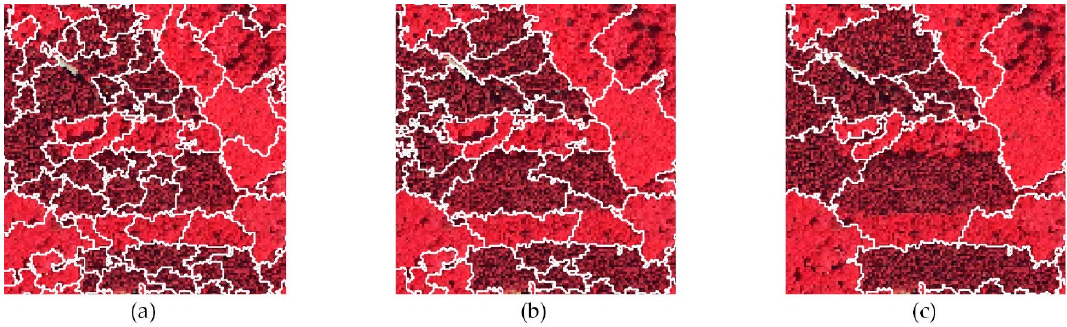
Figure 6. Results of the region growing segmentation on forest area No. 4 on RGBnIR imagery with a threshold ( a ) 0.44; ( b ) 0.46 (optimal); ( c ) 0.49